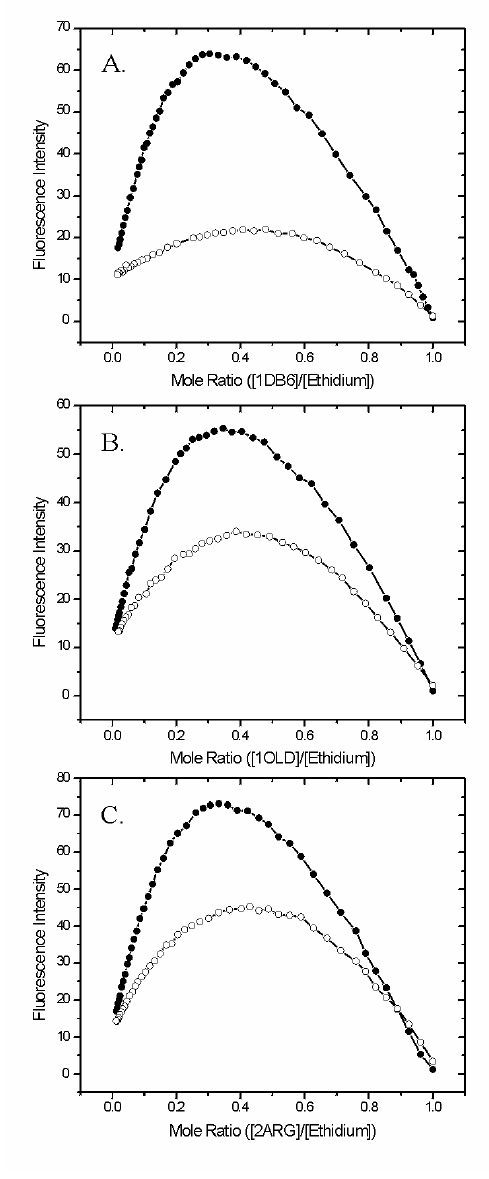
Figure 5. Effect of L-argininamide on the binding stoichiometry between ethidium and the L-argininamide binding DNA aptamers. Panels A, B, and C are job plots for 1DB6, 1OLD, and 2ARG respectively. In each case, Job plots were determined in the absence (solid circles) and presence (open circles) of 6.0 mM